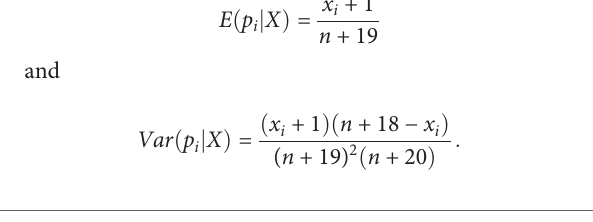
TABLE 1 | Fishing area in the central-south